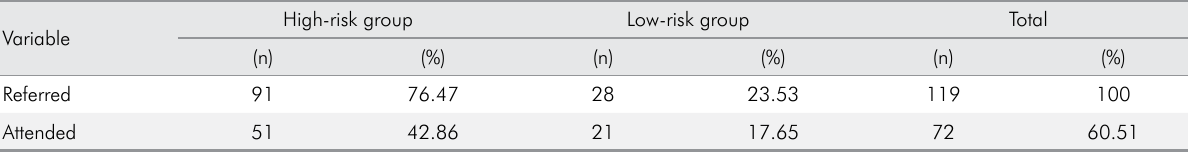
Table 2. Frequency of patient referral and provided care per groups, Piracicaba, Brazil, 2019–2021. Variable